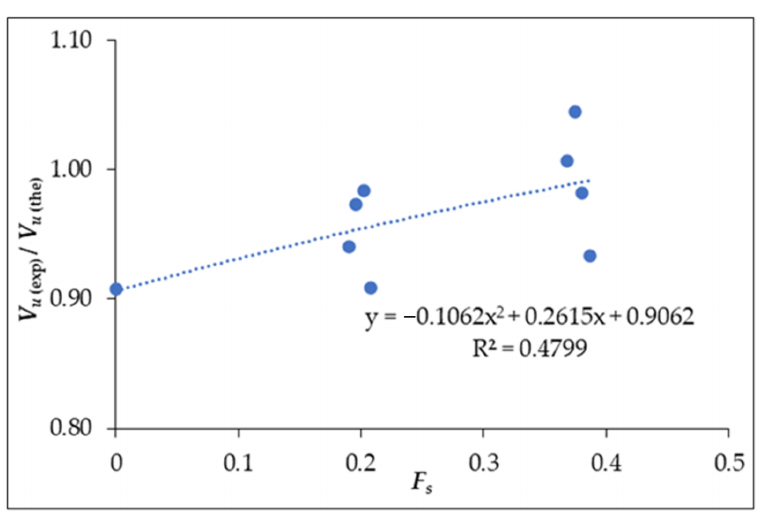
Figure 6. Correction factor ( F s ) against V u (exp)/ V u (the) . To predict an equation for obtaining the ultimate shear strength of HTGPC beams ( V u (pre) ), Equation (10) is modified by replacing V u (exp) with V u (pre) . Thus, the modified equation for predicting the shear strength of HTGPC is obtained as,